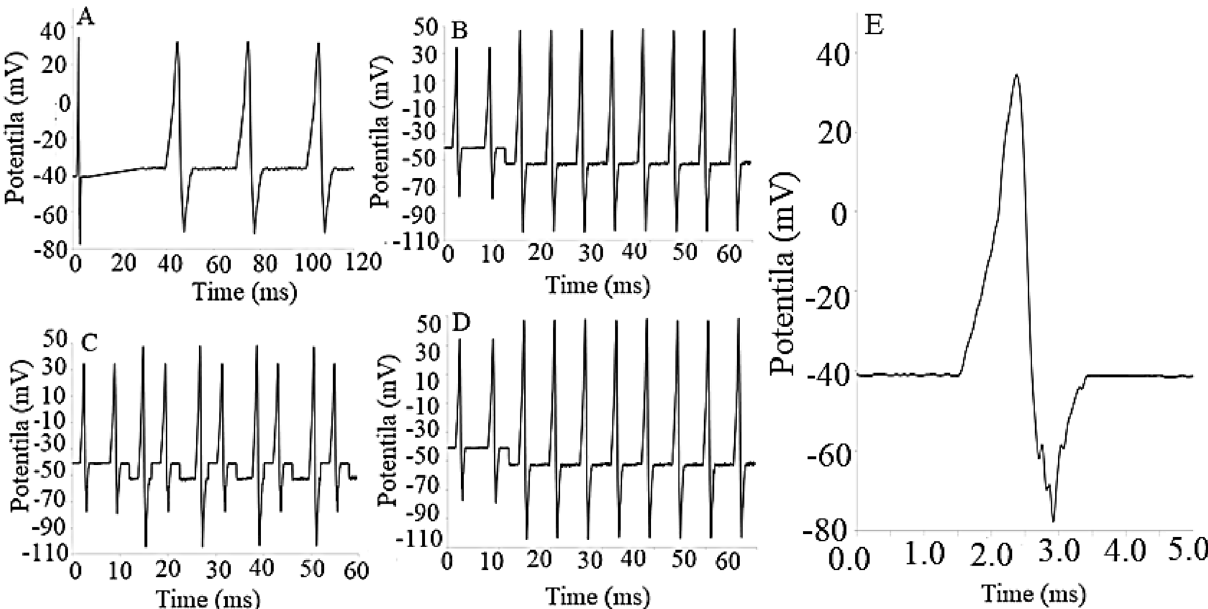
Figure 5. Action potential of neuron snail including ( A ) Control, ( B ) Noise modulated AP, ( C ) Stimulated potential modulation AP, ( D ) reproducible modulation/demodulation during voltage modulation on the AP and ( E ) Specificity of the hyperpolarization zone on the neuron sensitivity. Note : The potentials were estimated by potentiometry versus pseudo reference micro-electrode at the giga seal conditions using the two micro- electrode